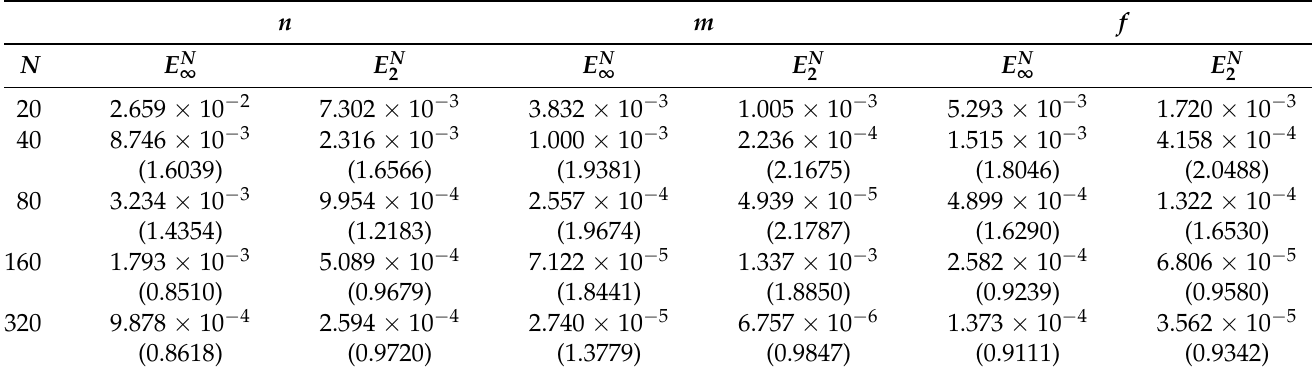
Table 5. Errors and convergence rates (bracketed) in different norms, Example 2.